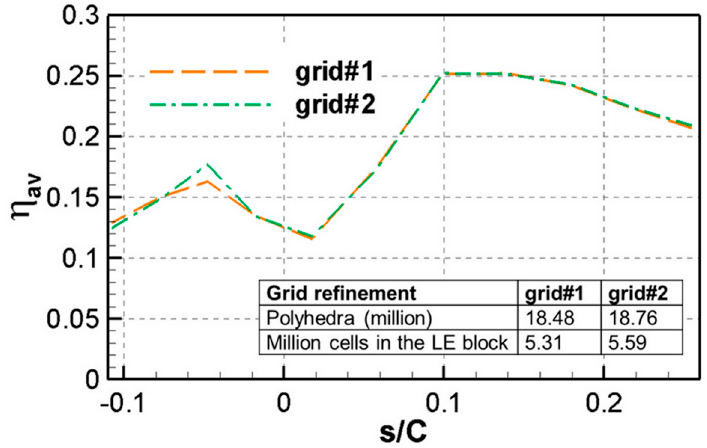
Figure 6. Example of grid resolution test at blowing ratio BR = 3. Shear stress transport (SST) k ω predictions of laterally-averaged film cooling effectiveness ( η av ).